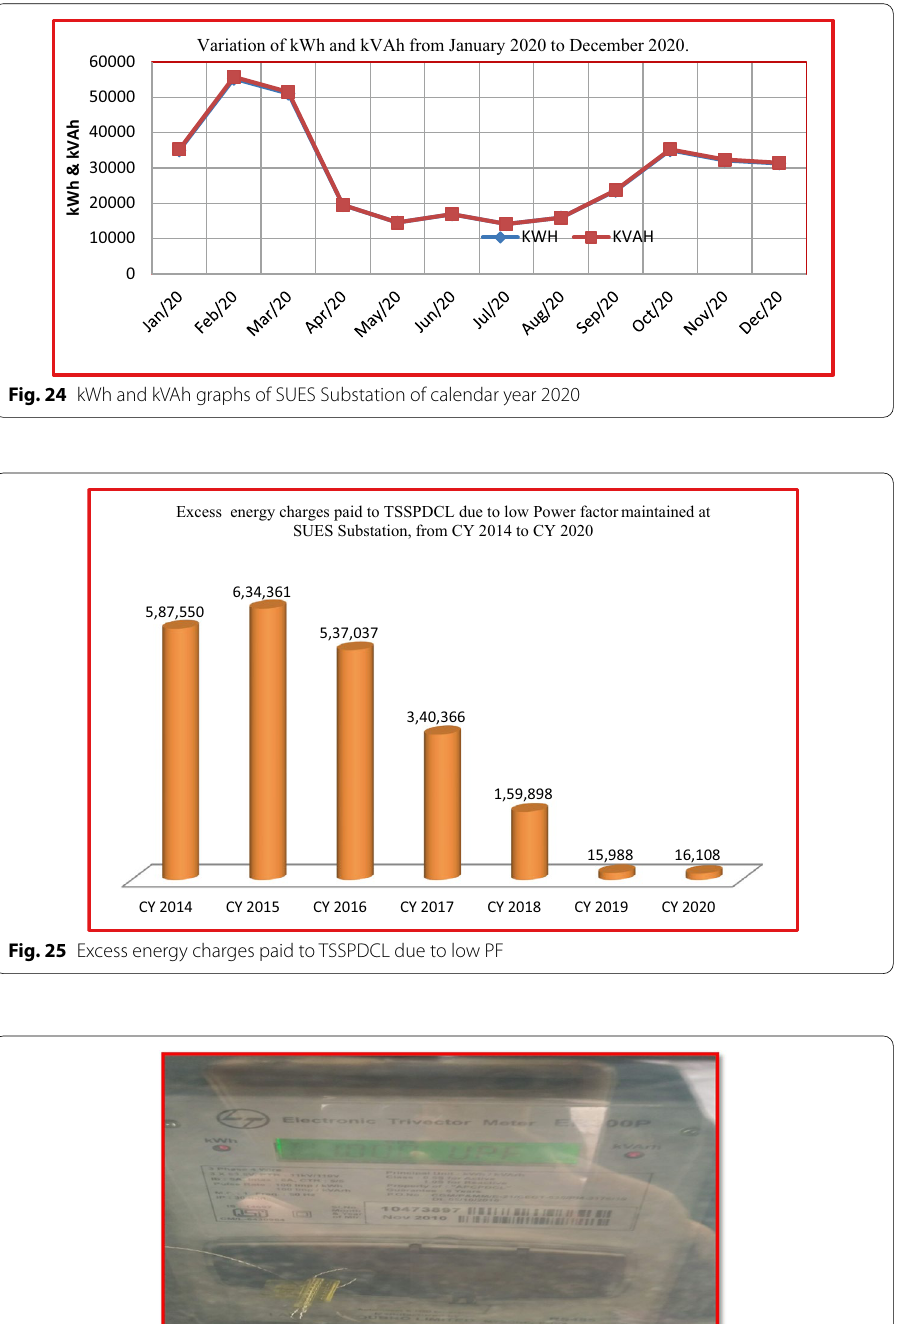
Fig. 26 Status of substation main incoming energy